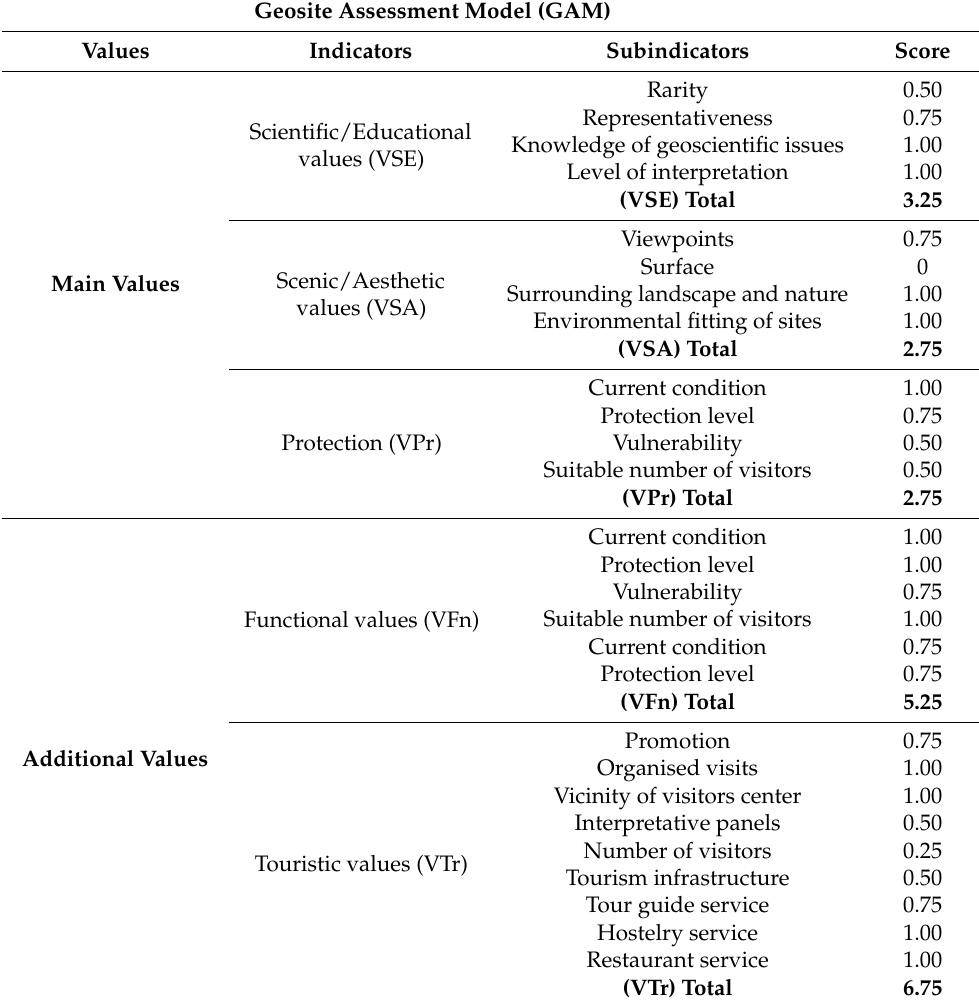
Table 4. Evaluation score for each indicator of the main or additional value of the GAM, applied to the MMMT.